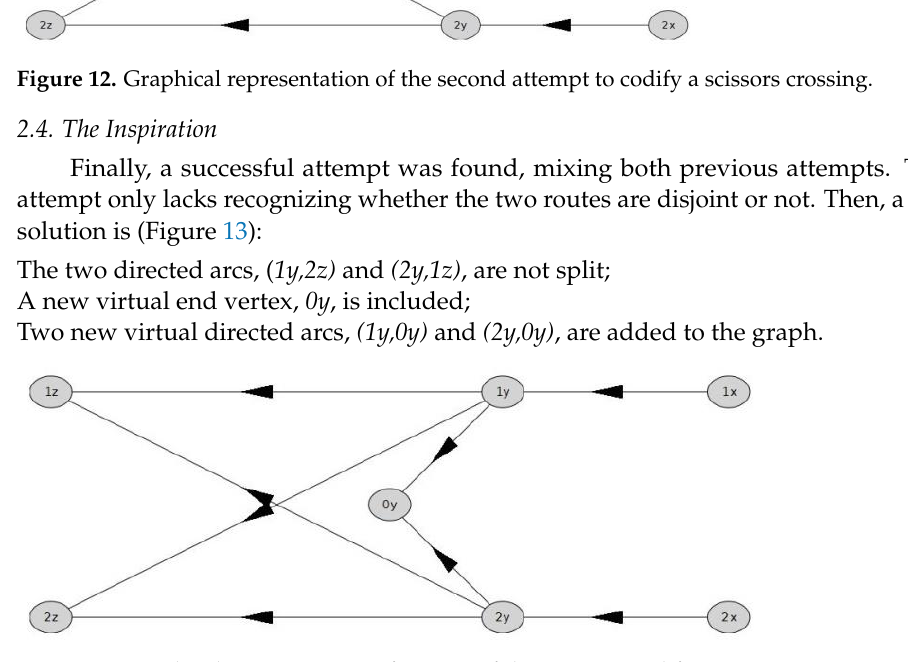
Figure 12. Graphical representation of the second attempt to codify a scissors crossing.